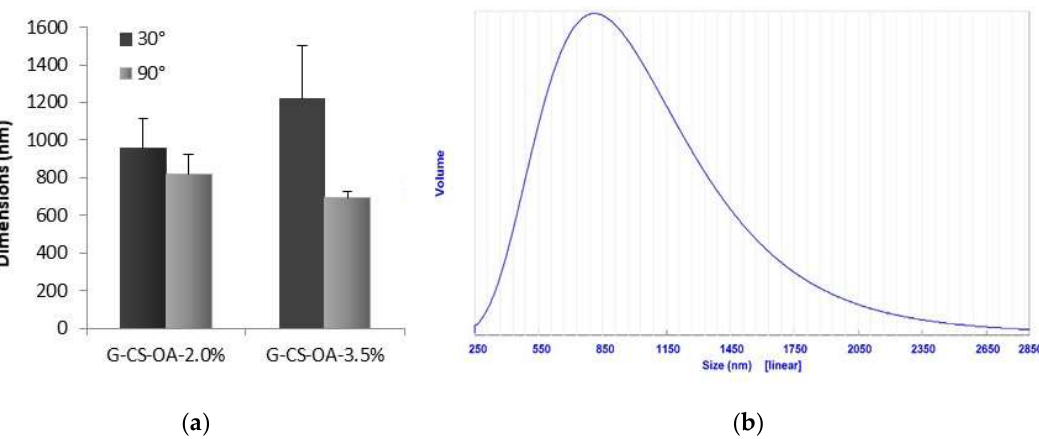
Figure 2. Dimensional characterization of the dispersed phase of geraniol in o/w emulsions. ( a ) mean values obtained from volume distributions (mean ± S.D., n = 3), ( b ) example of volume distribution recorded at 90° of detection angle (G-CS-OA-2.0% sample).